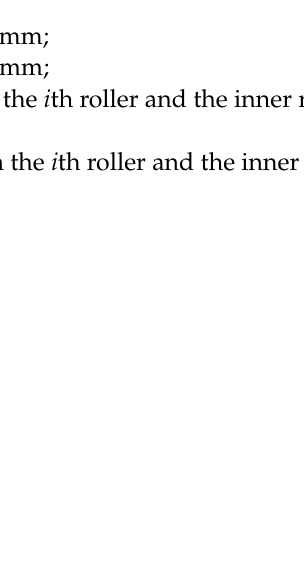
Figure 3. The relative positions of the i th roller and the inner ring with the inner ring